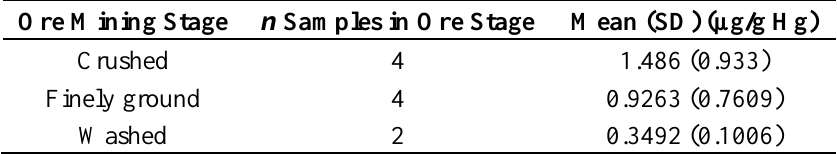
Table S2. Kejetia ore Hg